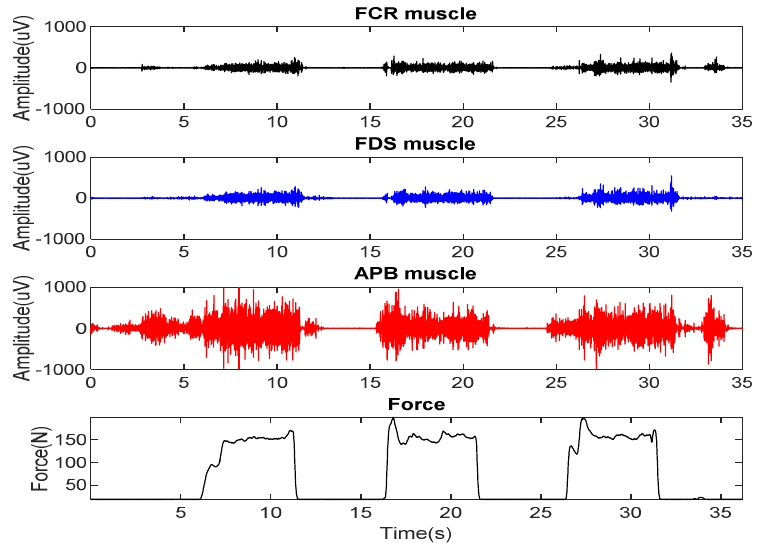
Fig. 4. A plot of the EMG for the power grip with 50% MVC for participant 1 (male participant). The top 3 figures represent the 3 trials of EMG from the FCR, FDS and APB, respectively. The bottom figure is the force signal measured in Newton with hand dynamometer.